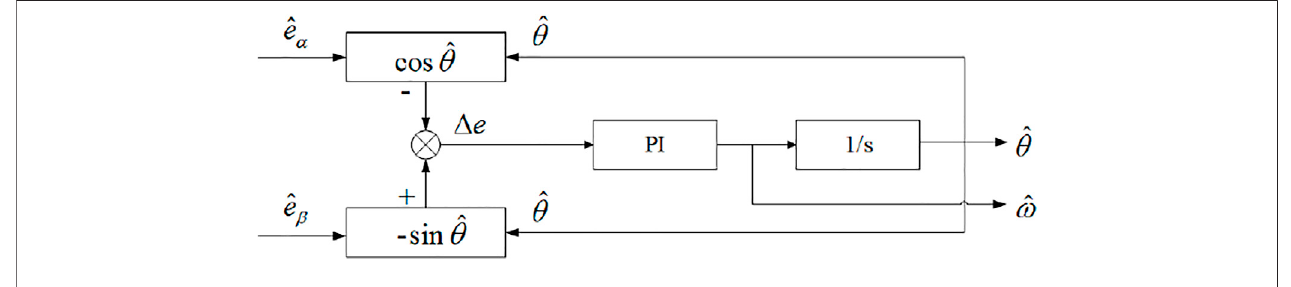
FIGURE 4 | Block diagram of PLL